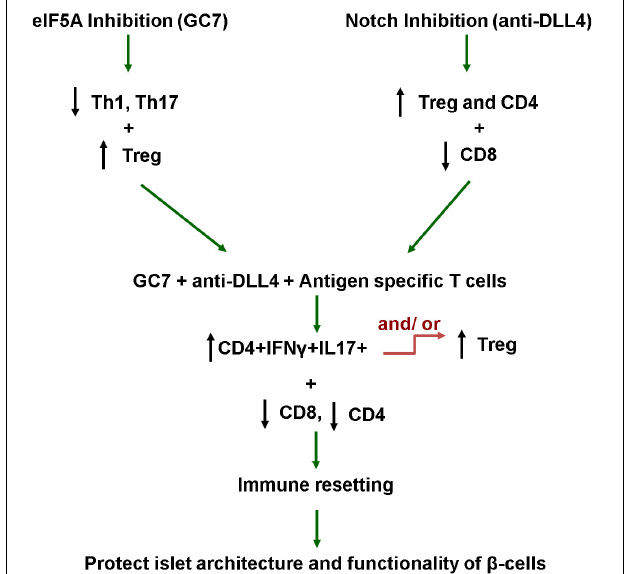
FIGURE 8 | Working hypothesis. This study explains that elF5A and Notch signaling inhibition favors the reversal of the pro-inflammatory milieu, enriching the Treg population in the pancreatic microenvironment (PLN and PN), and restraining the antigen-specific CD8-mediated destruction of β -cells. This study also explains that the plasticity of IL-17 + IFN γ + producing CD4 cells toward Treg phenotype is proportional to the increased proliferative capacity of IL-17 + IFN γ + producing CD4 cells. These interventions tip the pro-inflammatory balance toward regulation and protect/rescue T1D mouse islet β -cells from autoimmune